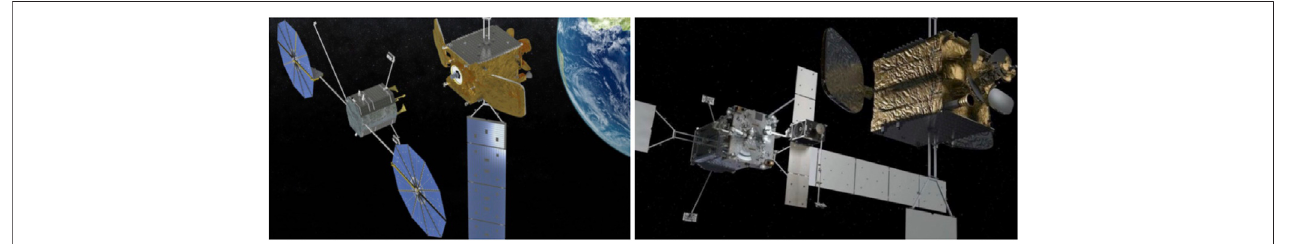
FIGURE 10 | Northrop Grumman ’ s (A) MEV (Orbital ATK), and (B) MRV (Grumman, 2021).